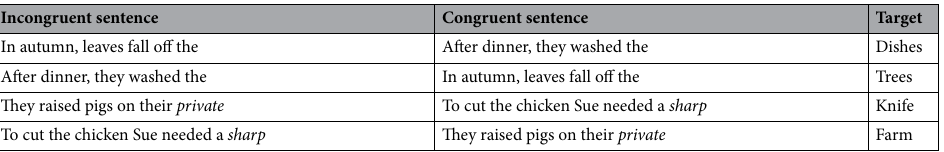
Table 1). The remaining 140 sentences were recorded by a female, native Australian-English speaker. In order to make sure that the congruent sentences were highly congruent for children, eighteen native English speaker